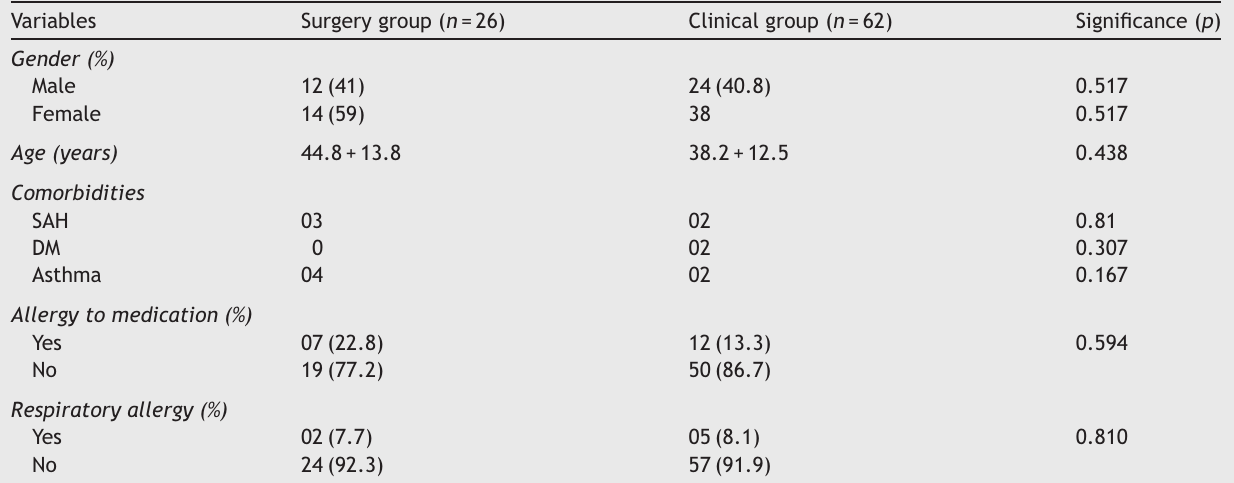
Table 1 Sociodemographic characteristics of patients with chronic rhinosinusitis referred for surgery (surgery group) and of patients with chronic rhinosinusitis referred for clinical treatment (clinical group). Variables